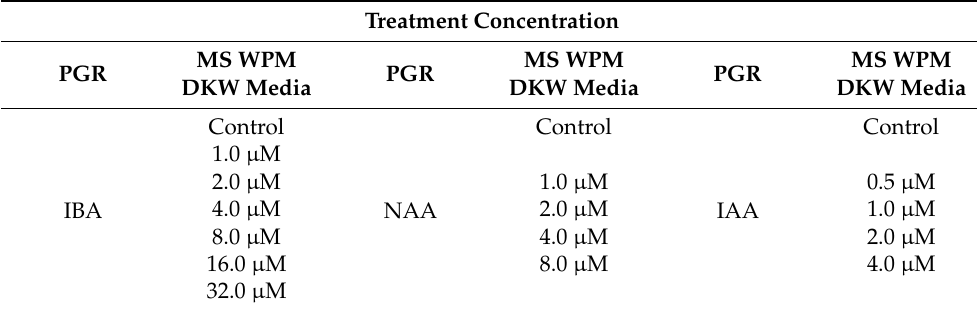
Table 2. Treatments used in the rooting experiments for both the female and male